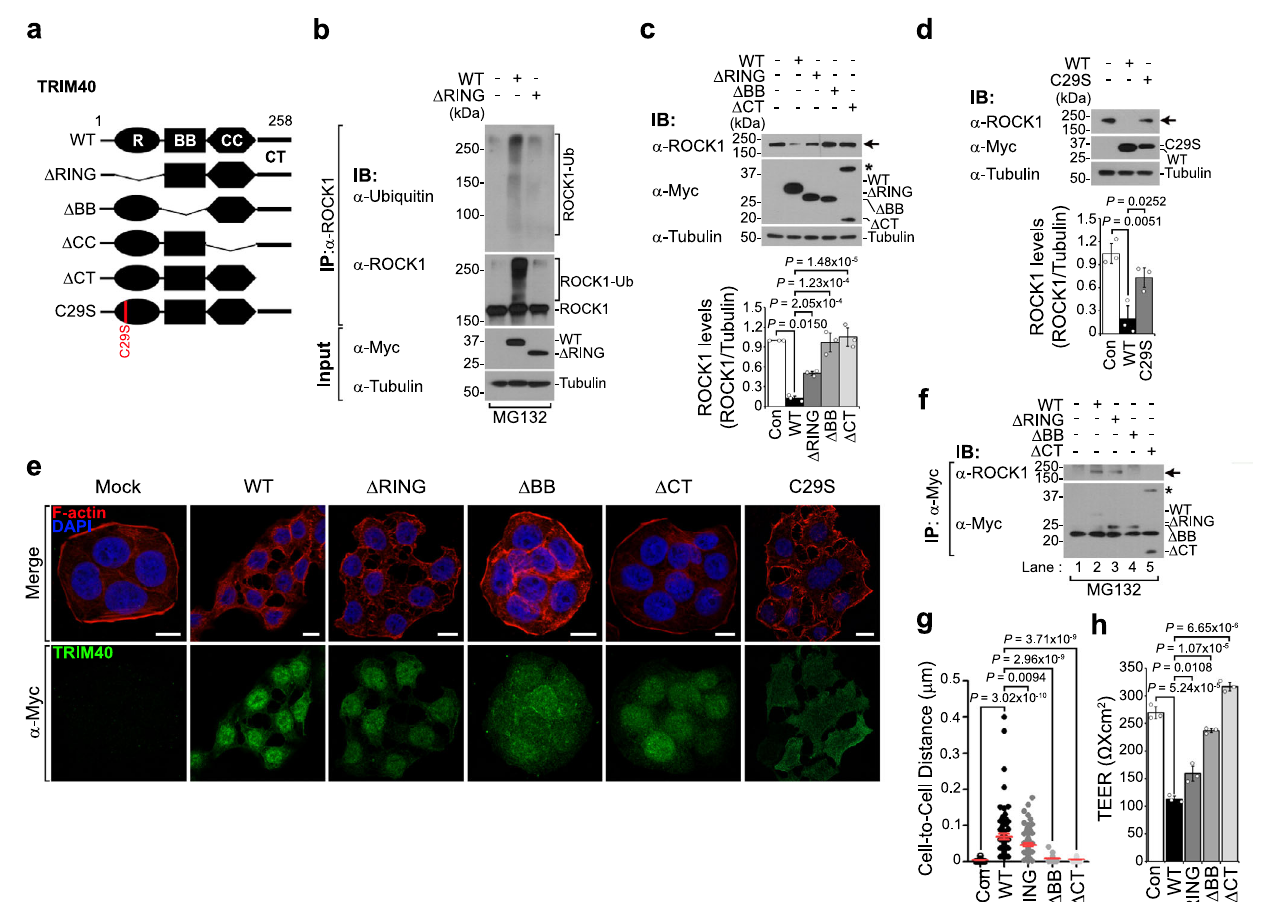
Fig. 4 | The RING, B box, and C-terminal domains of TRIM40 are required for ROCK1 degradation. a Schematic representation of full-length TRIM40 (WT) and TRIM40 mutants. Δ RING, Δ BB, Δ CC, or Δ CT lacks RING, B-box, coiled-coil, or C-terminalregion,respectively.TRIM40-C29Ssubstitutescysteinewithserineat29 residue. b Immunoblots showing ROCK1 ubiquitination in control vector-, WT- TRIM40-,orTRIM40 Δ RING-expressingHT-29cells. c ImmunoblotsofROCK1levels inHT-29cellsexpressingWT-TRIM40orTRIM40mutants.Quanti fi cationofROCK1 band intensity relative to tubulin band intensity (bottom graph). The asterisk, dimeric forms of TRIM40 Δ CT. d Immunoblot analysis of ROCK1 levels in HT-29 cells expressing control vector, WT-TRIM40, or TRIM40-C29S. Quanti fi cation of ROCK1 band intensity relative to tubulin band intensity in lysates (bottom graph). e ConfocalimagesshowingcorticalF-actininHT-29cellsexpressingcontrolvector, WT-TRIM40,TRIM40deletion,orTRIM40-C29S.Cellswerestainedwithphalloidin for cortical F-actin (red) and anti-Myc antibody for WT-TRIM40, TRIM40 deletion, or TRIM40-C29Smutants(green).NucleiwerestainedwithDAPI(blue).Scalebars,